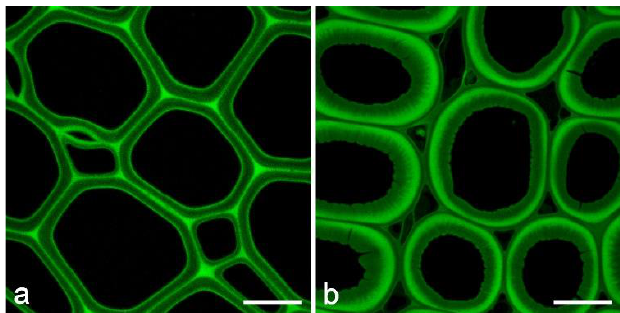
Figure 5. Autofluorescence of lignin in pine wood. ( a ) TS of normal pine wood (excitation at 458 nm, emission at 465 – 700 nm). Scale bar = 15 µm. ( b ) TS of pine reaction wood showing the altered emission at 465–700 nm). Scale bar = 15 µ m. ( b ) TS of pine reaction wood showing the altered distribution of lignin (excitation at 458 nm, emission at 465 – 700 nm). Scale bar = 15 µm. distribution of lignin (excitation at 458 nm, emission at 465–700 nm). Scale bar = 15 µ